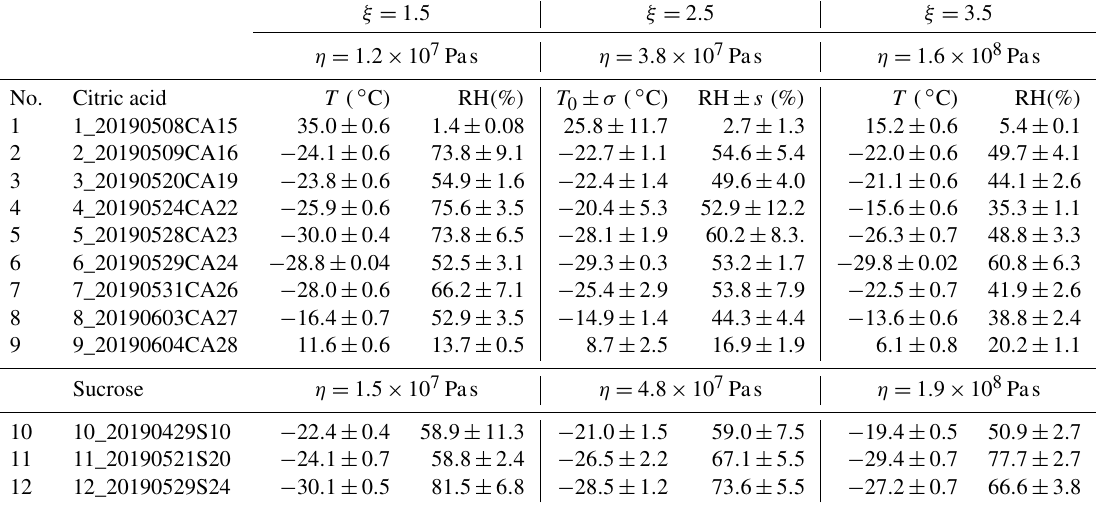
Table 2. Data summary for each experiment. The viscosity is evaluated at ξ = 1 . 5 , 2 . 5, and 3 . 5. The corresponding viscosity is calculated based on the surface tension (Table 1), size (90nm), and coagulating time (60s). The second column includes an experiment identifier to link the figures in the Supplement and the data repository. T 0 ± σ corresponds to the midpoint of the relaxation as determined from the fit of the data to Eq. (1). RH ± SD corresponds to the standard deviation in RH in the interval [ T 0 − σ,T 0 + σ ] . The temperatures and standard deviation in columns ξ = 1 . 5 and ξ = 3 . 5 correspond to the mean and standard deviation in the interval [ (T 0 − σ) − 1 ,(T 0 − σ) + 1 ] and [ (T + σ) − 1 ,(T + σ) + 1 ] , respectively, and their corresponding RH values. 0 0 ξ = 1 .